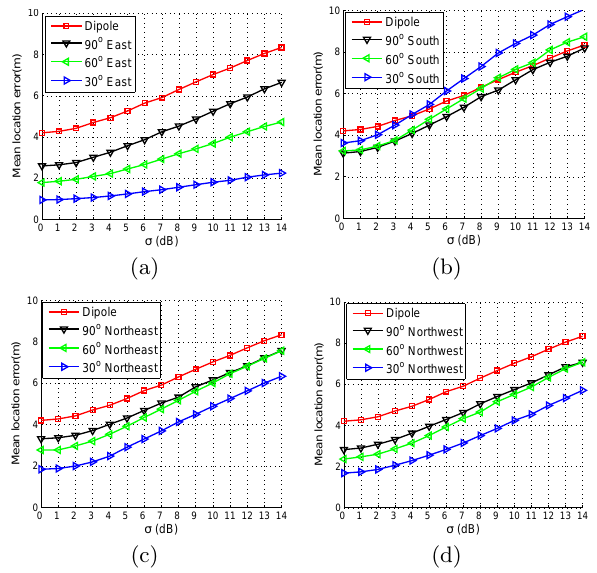
Figure 7: Mean location error vs. noise standard de- viation (cid:27) : (a) dipole and east, (b) dipole and south, (c) dipole and northeast and (d) dipole and north-